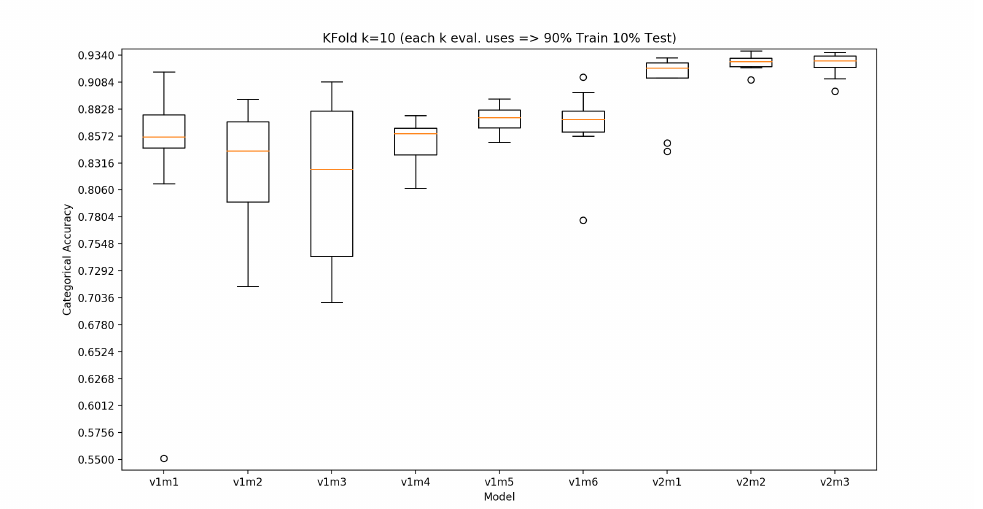
Figure 6. K-fold (k = 10) test accuracy for selected models on the IGN-PNOA